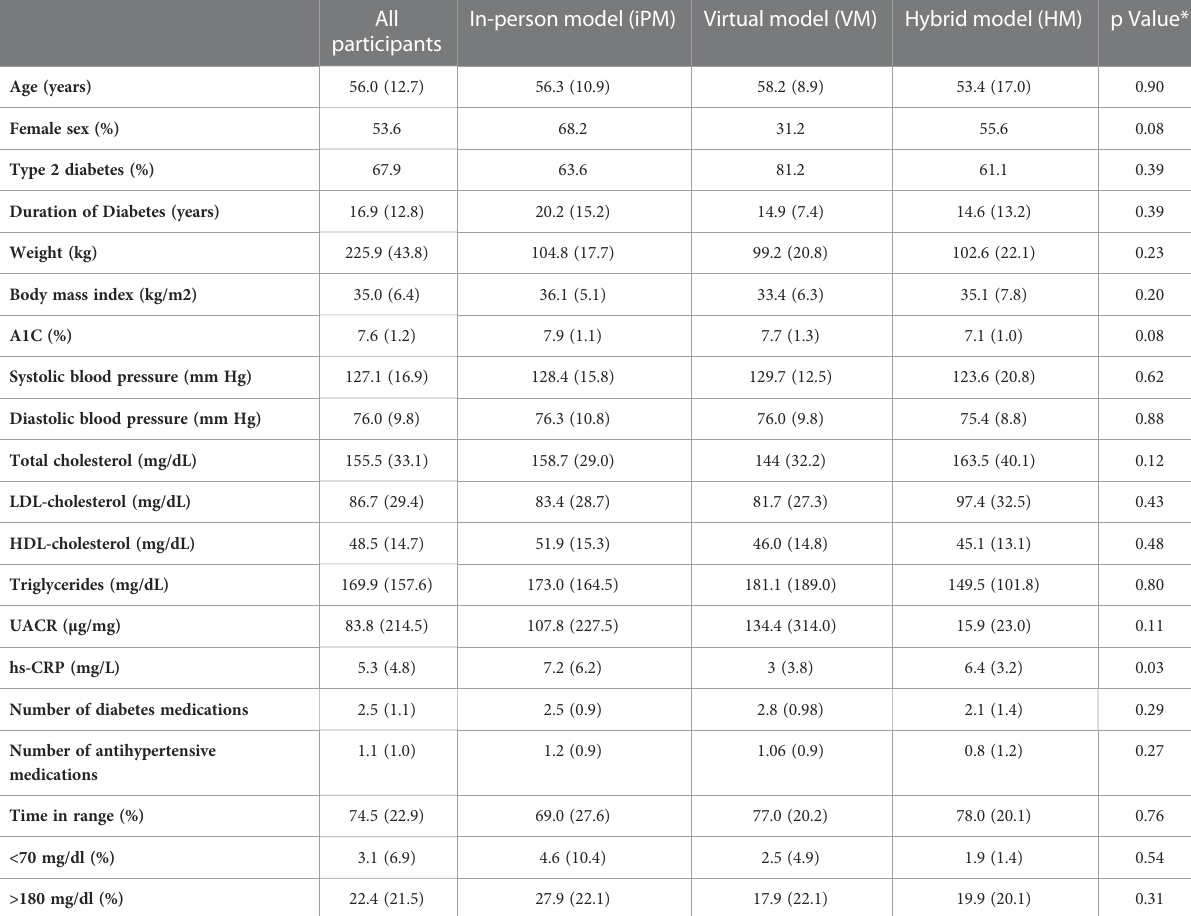
TABLE 1 Baseline characteristics of participants in real-world intensive lifestyle intervention.